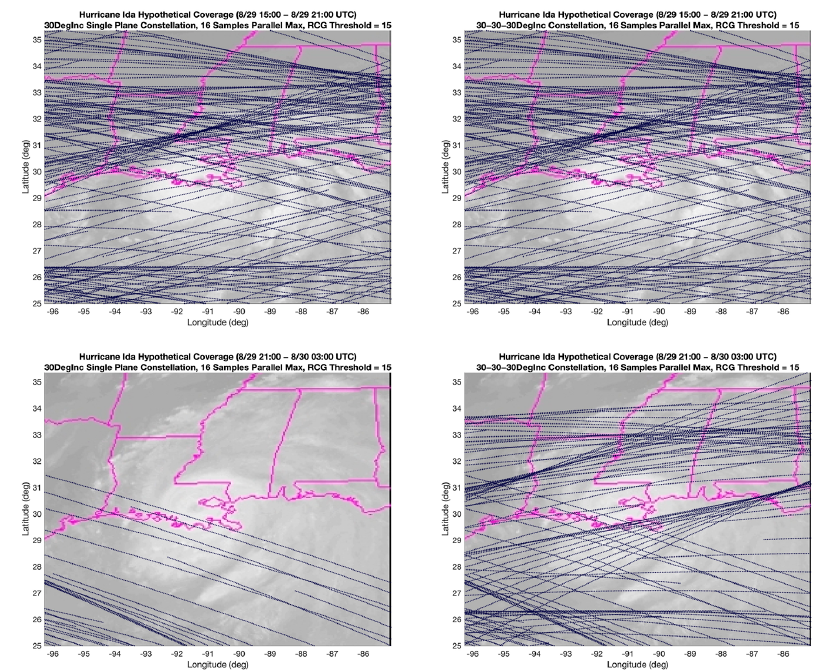
Figure 10. Simulated measurements by two GNSS-R constellations of Hurricane Ida during landfall on 29 August 2021. The left column corresponds to an 8-satellite constellation and the right to one with 24 satellites, all at 30° inclination. Rows correspond to 6 h time intervals centered on 0600, 1200, 1800 and 2400 UTC. GNSS-R tracks are overlaid on GOES-16 Band 8 (6.17 μ m) images at the center times. Landfall occurred at 1655 UTC.